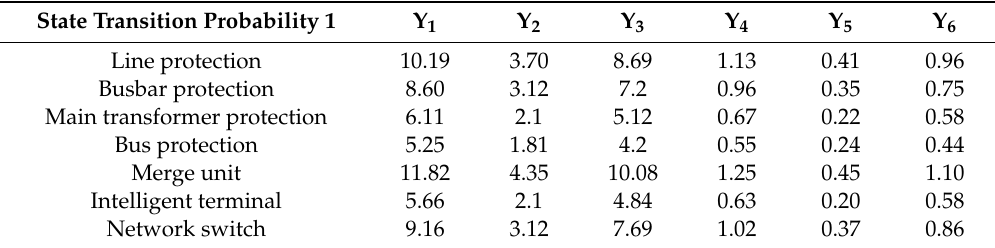
Table 1. State transition probability 1 (10 − 5 h − 1